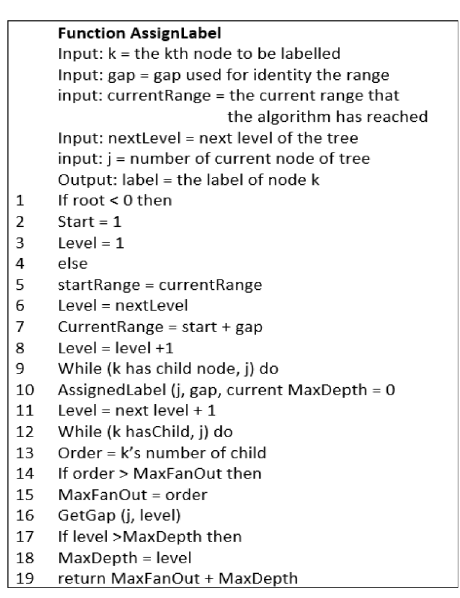
Figure 3(b). Algorithm for Function